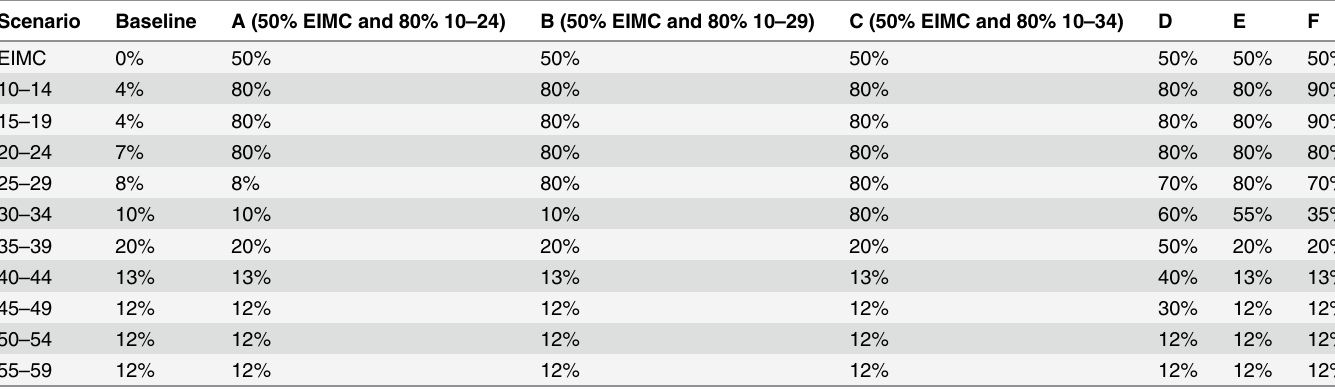
Table 1. Swaziland Age-targeting Strategy Scenarios.